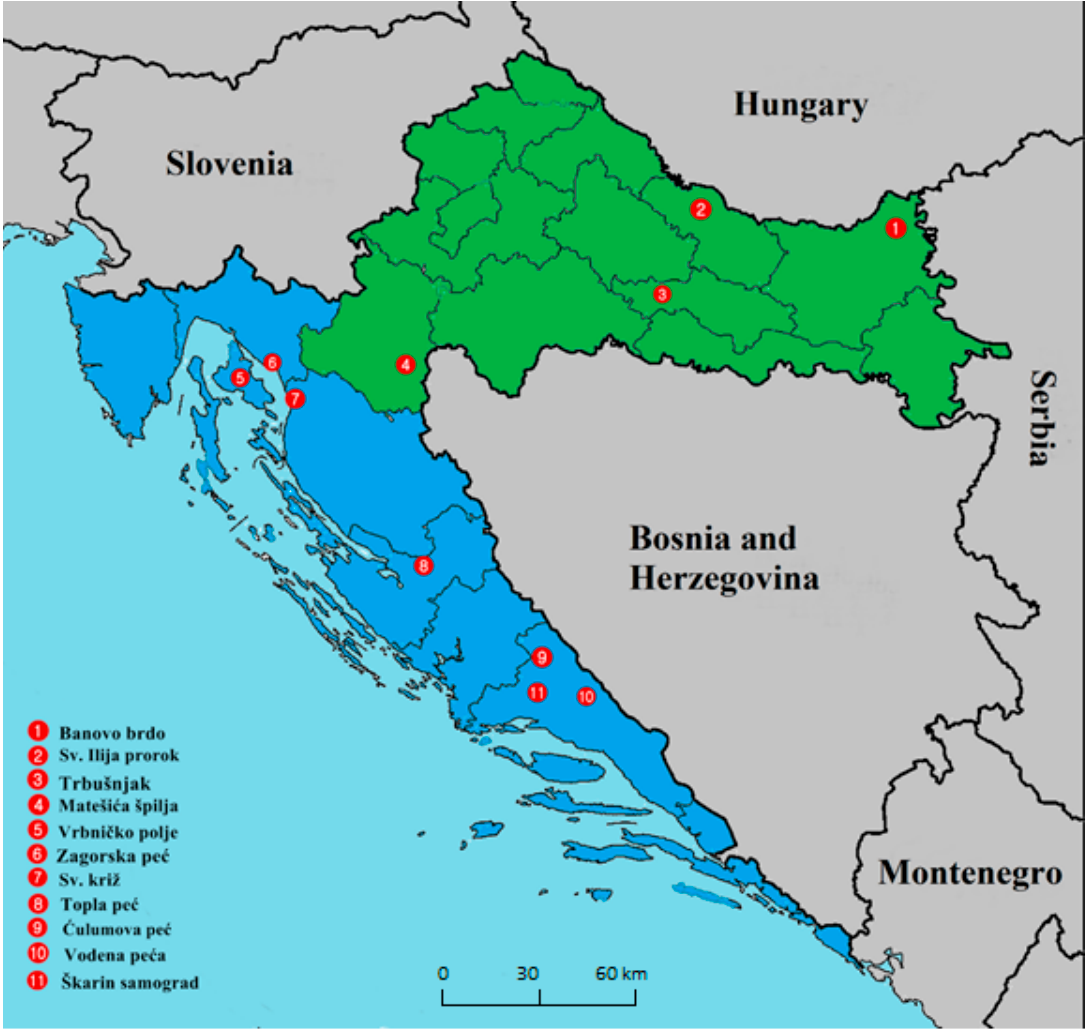
Figure 1. Locations of bat sampling in continental (green) and Mediterranean (blue) Croatia. Source: